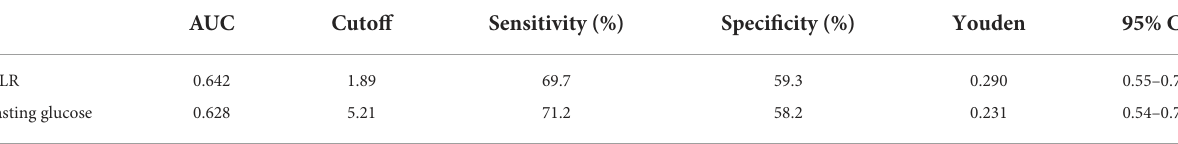
TABLE 3 Results of receiver operating characteristic analysis of NLR and other markers in CI.